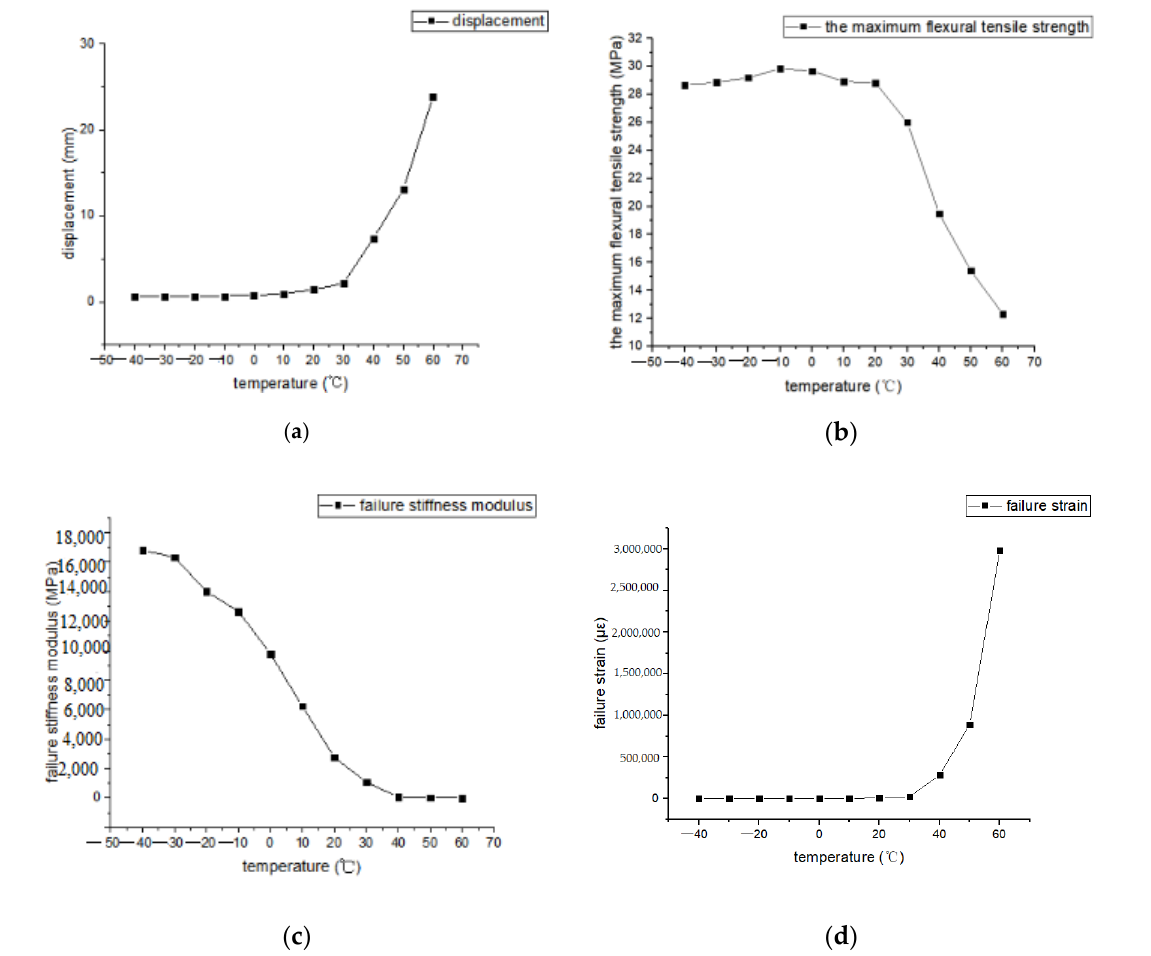
Figure 16. The flexural tensile strength of polyurethane concrete at different temperatures. ( a ) Deflec- tion; ( b ) Flexural tensile strength ( c ) Stiffness modulus ( d ) Flexural tensile